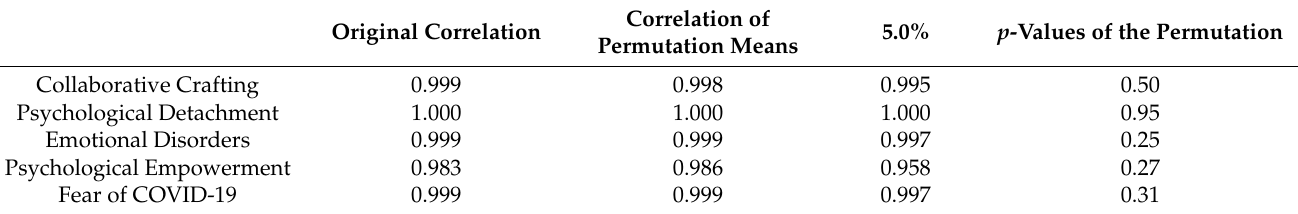
Table 5. MICOM. Stage 2 results.